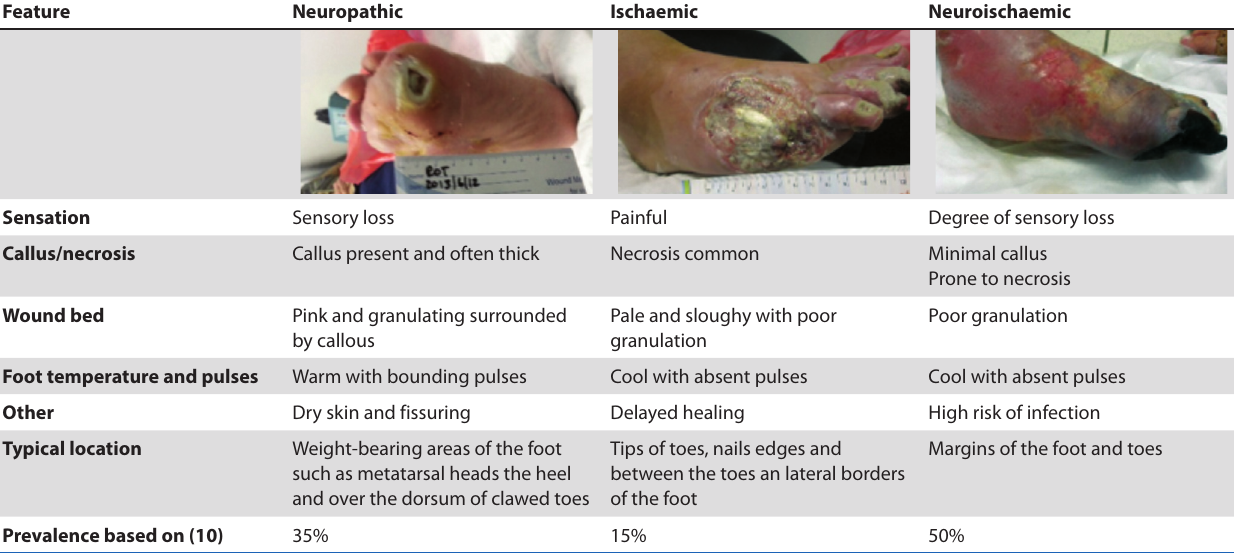
Table 5: typical feature of DFUs according to aetiology adapted from best practice guideline 2013 5